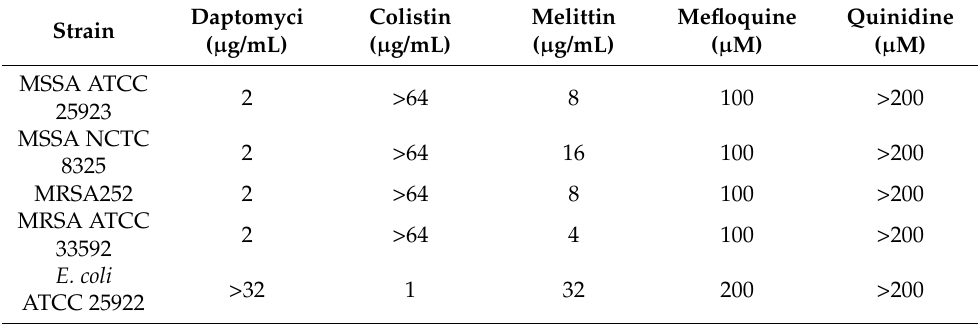
Table 1. Minimum inhibitory concentrations (MICs) of select